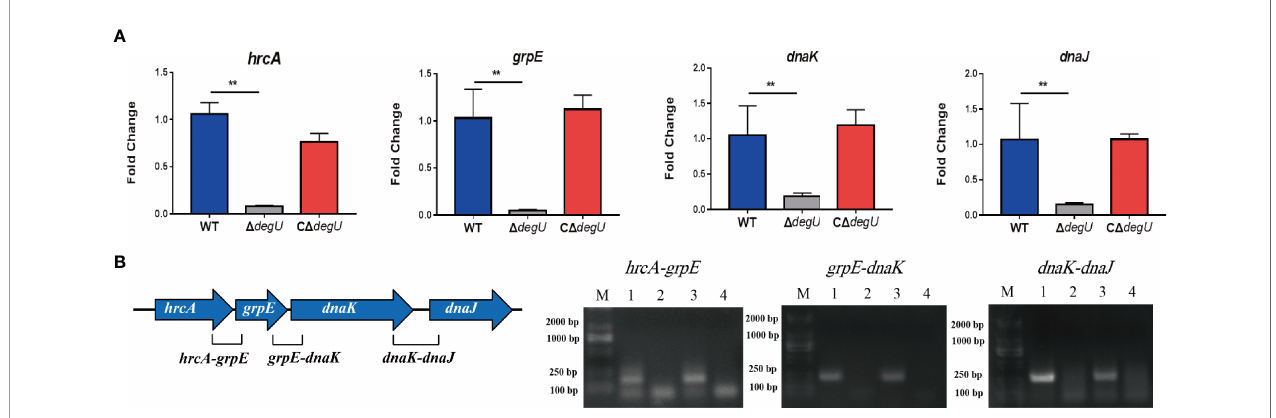
FIGURE 2 | hrcA-dnaJ transcription is activated by DegU. (A) The relative mRNA levels of hrcA, grpE, dnaK, and dnaJ as determined by RT-qPCR in WT, D degU , and C D degU strains at 43°C. (B) Schematic diagram showing the gene order. Co-expression results con fi rmed that the hrcA, grpE, dnaK, and dnaJ genes form an operon under heat-stress conditions. Lane 1, cDNA; lane 2, total RNA; lane 3, genomic DNA; and lane 4, no-template control. Data are presented as the means ± S.D. of three independent experiments. ** p <